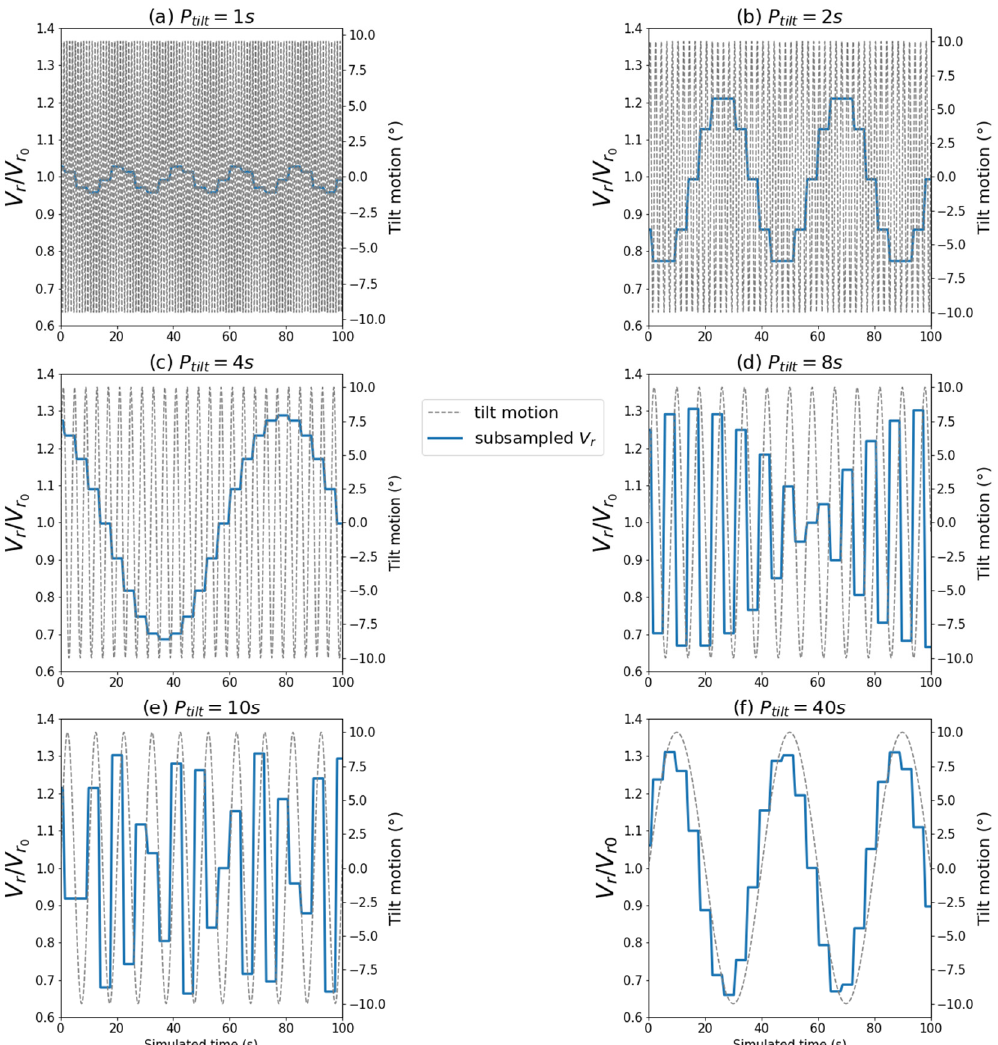
Figure 9. Example of the subsampling and averaging effect on the radial wind speed measurement of beam A described in Section 4.2.2 subjected to a sinusoidal tilt T of amplitude a tilt = 10 ◦ . The radial wind speed measured by the ray (in blue) is normalized by the value measured in a motionless case V r . Different periods of tilt are evaluated: P = 1 s ( a ), 2 s ( b ), 4 s ( c ), 8 s ( d ), 10 s ( e ), 40 s ( f ). The tilt motion is displayed (in grey), the scale of the motion is displayed on the right hand side of the figures.